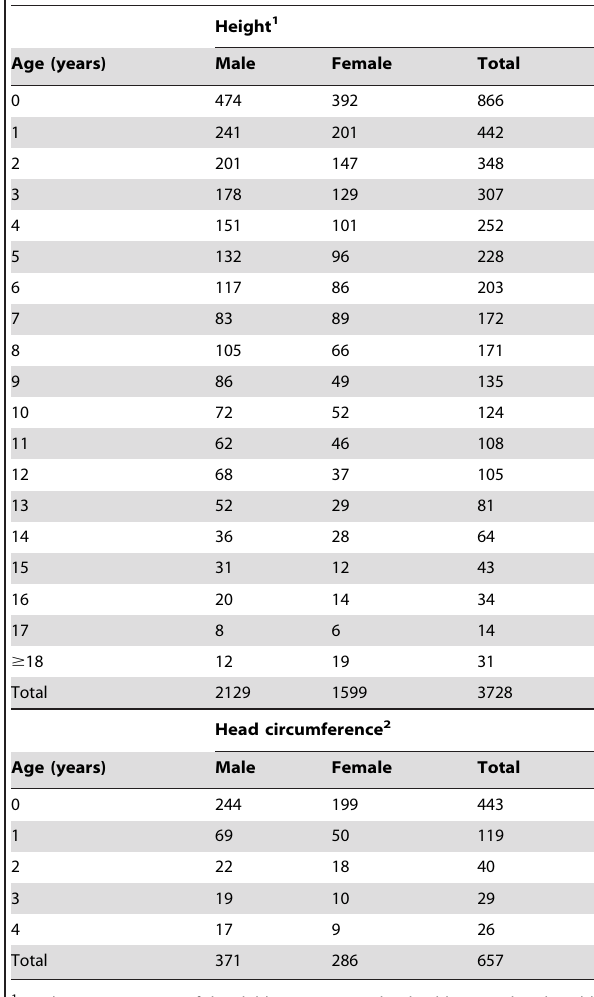
Table 3. Frequencies of measurements for height used for plotting the reference curves for Dutch children with Down syndrome, arranged by age and sex.